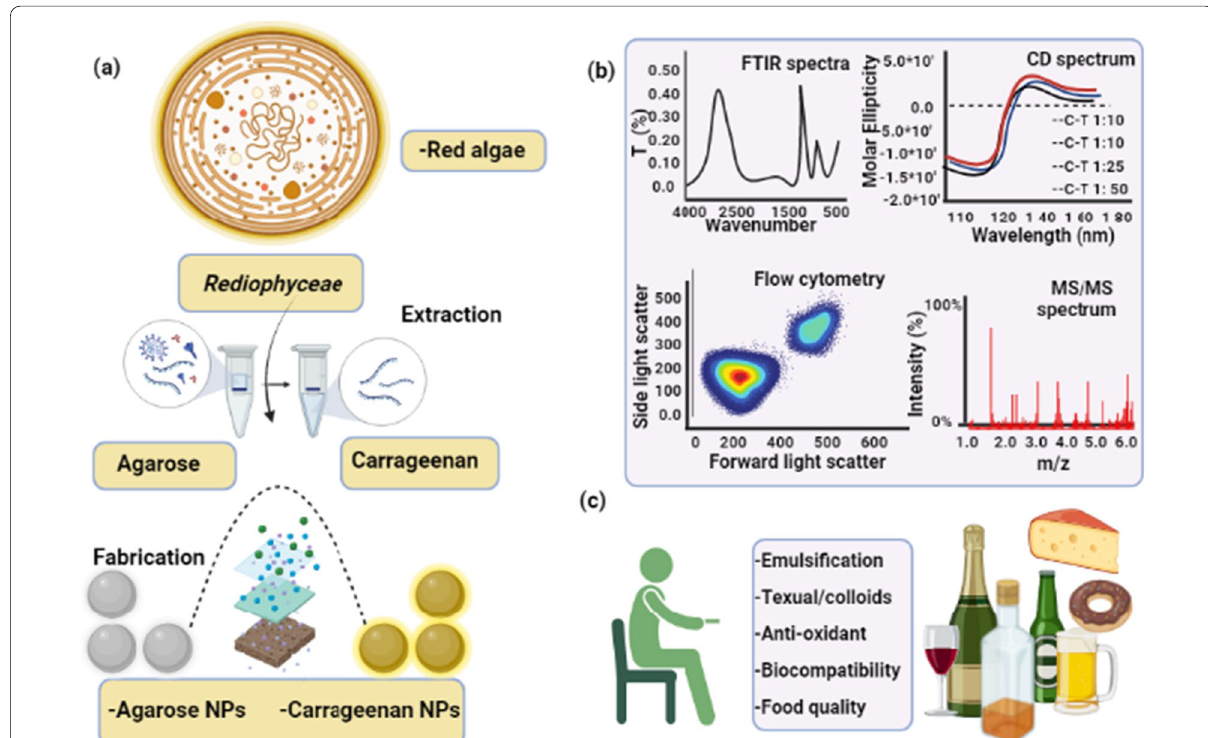
Fig. 2 a Complete diagram sketch of the derivation of polysaccharide from Rediophyceae /red algae, synthesis of agarose and carrageenan NPs, b characterization of carrageenan and agarose NPs with different parameters, c and its application in food